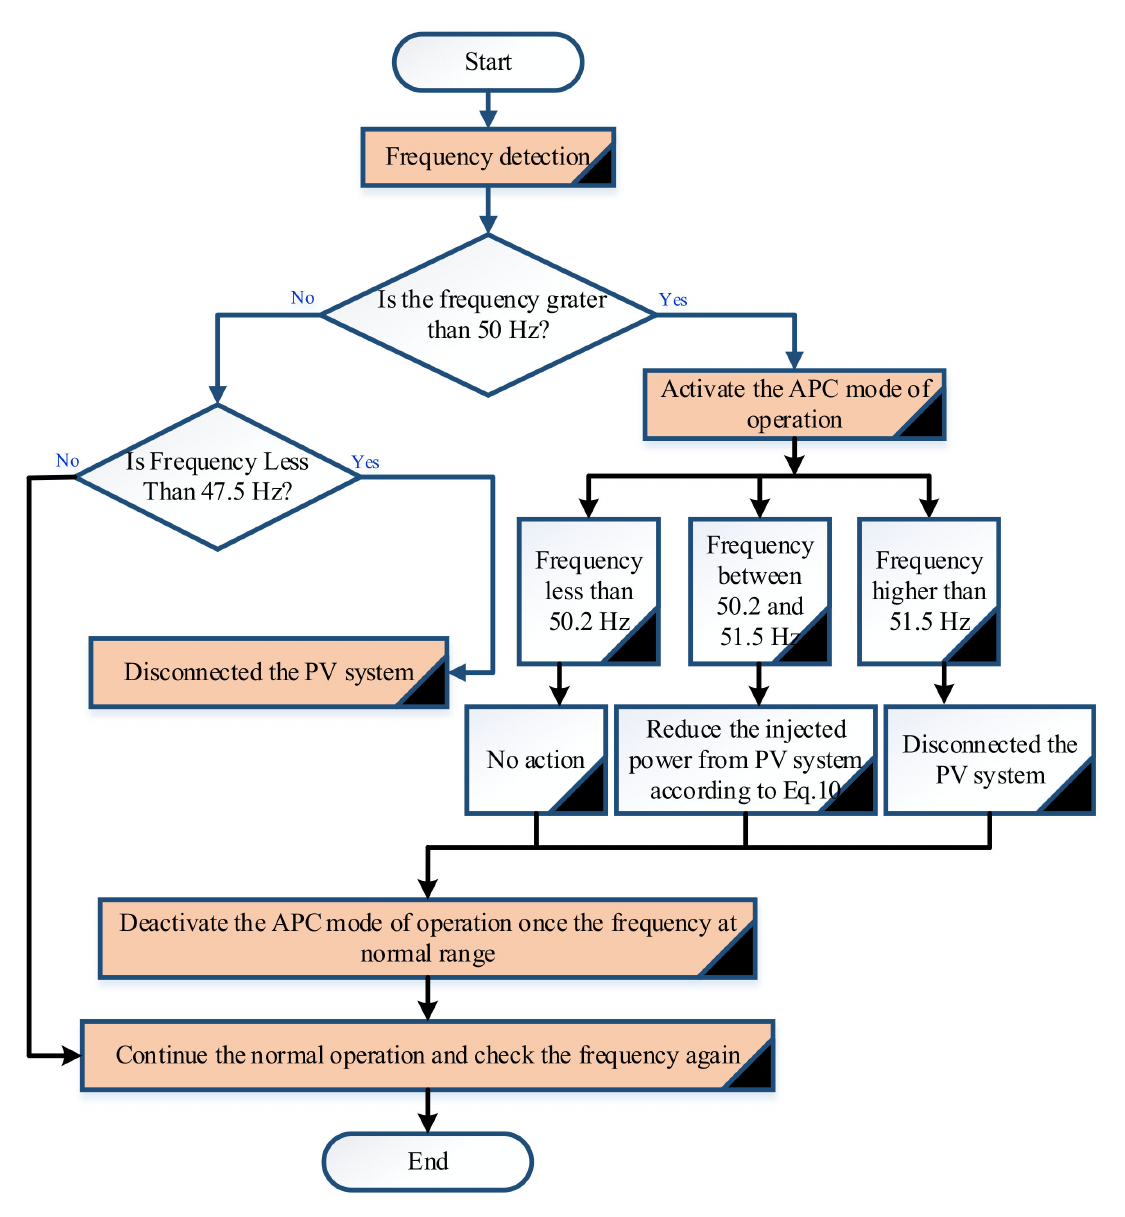
Figure 10. The system flowchart containing controller structure of the PV system with